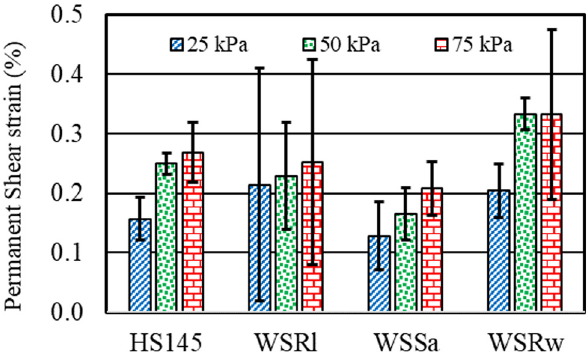
Figure 18: Permanent shear strain at each testing cycle of WMAs manufactured at 125°C.